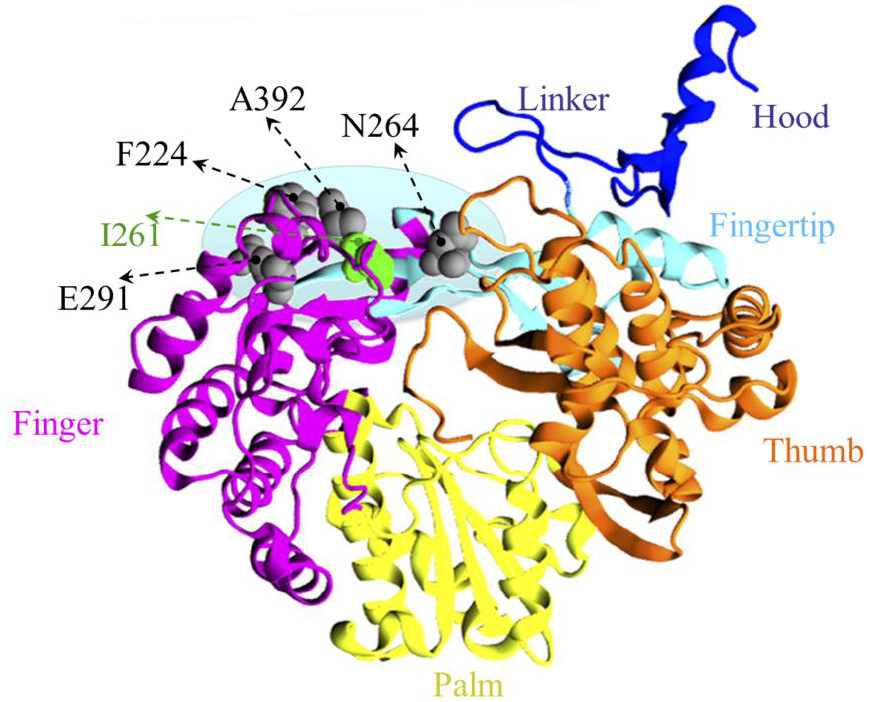
Figure 7. The mutational perspective of BVDV-RdRp. The palm, thumb, and finger domains are shown in the new cartoon representation, and colored in dark yellow, orange, and purple, respectively. The N-terminal and fingertip regions are shown in blue and cyan, respectively. Resistant mutations of different classes of NNIs, residues F224 (in loop L2), E291 (near the fingertip), N264 (in motif I of the fingertip), A392 (in loop L1), and I261 (in motif I of the fingertip) of 227G, are rendered in VDW and colored in gray and green, respectively. The location of resistant mutations is indicated by black